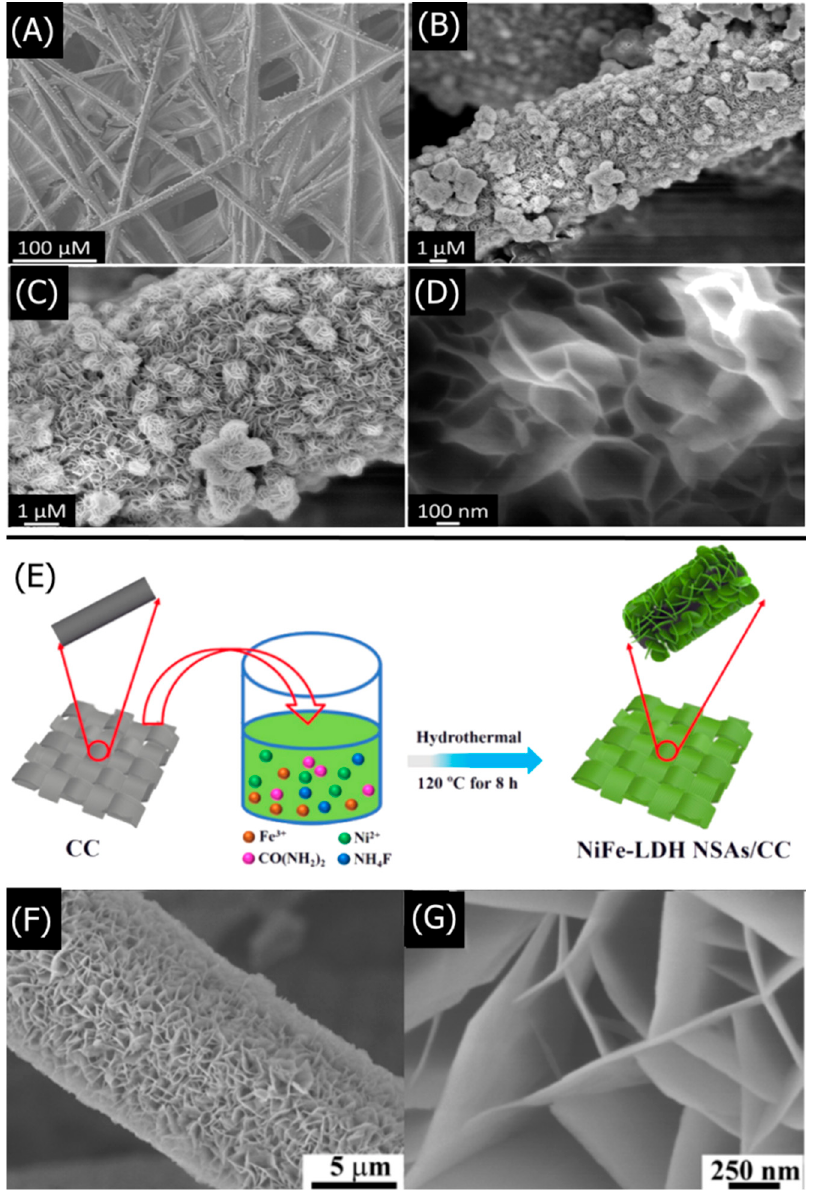
Figure 8. ( A – D ) SEM micrographs of MgAl-LDH/carbon paper at different magnifications, repro- duced from reference [141] with permission from Elsevier B.V., 2019; ( E ) schematic illustration of the synthesis of the NiFe-LDH/carbon cloth composite; ( F ) low- and ( G ) high-magnification SEM micrographs of the NiFe-LDH/carbon cloth composite, reproduced form reference [142] with permission from American Chemical Society, 2018.